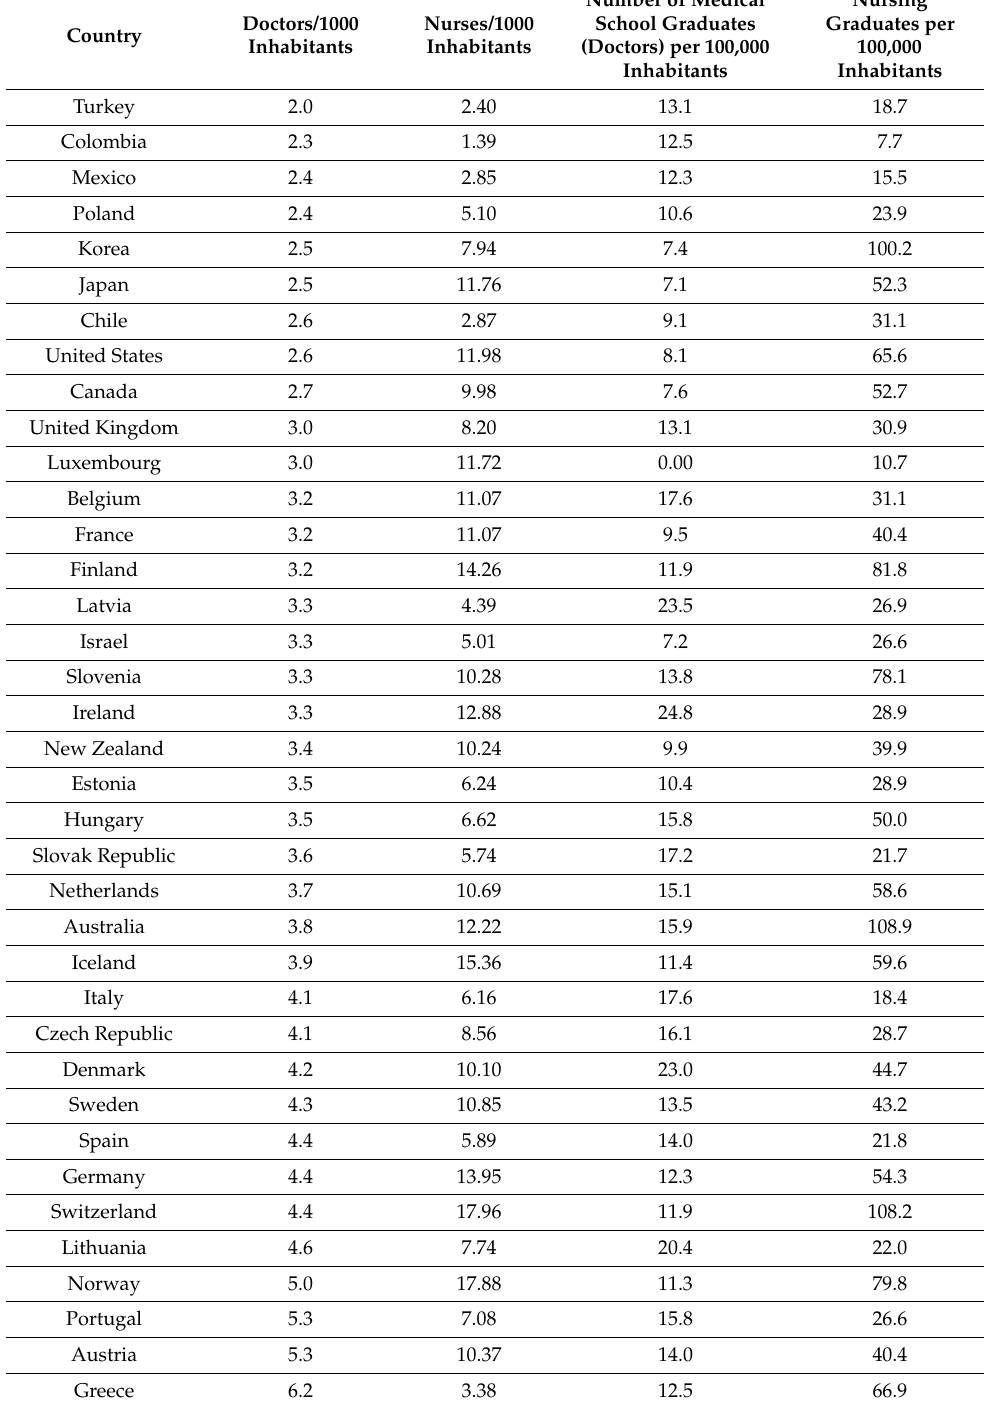
Table 2. Structure of doctors and nurses in selected OECD countries in 2019 [23].